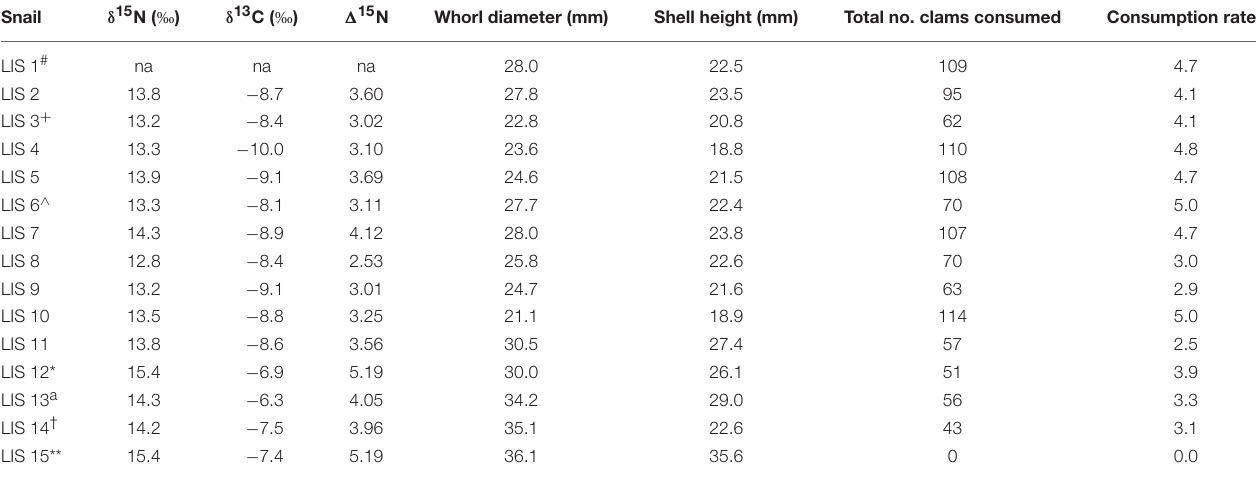
TABLE 1 | Isotopic signatures, discrimination factors, body size, and consumption rate for experimental Neverita duplicata . Snail δ 15 N ( ‰ ) δ 13 C ( ‰ ) 1 15 N Whorl diameter (mm) Shell height (mm) Total no. clams consumed Consumption rate ◦ LIS 1 # na na na 28.0